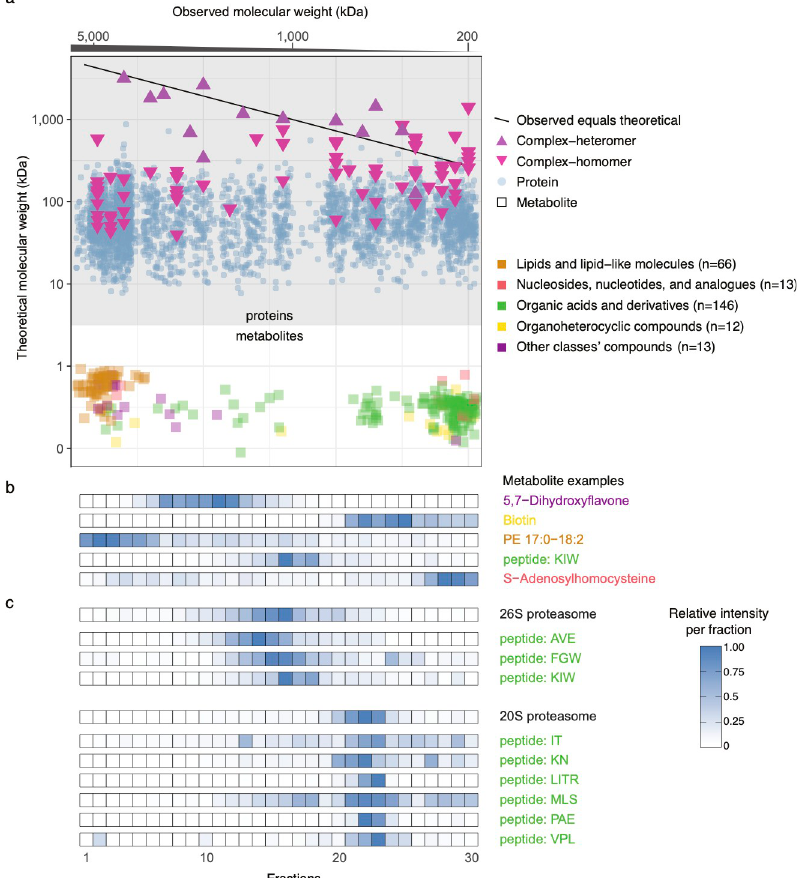
Fig 2. Identified proteins and metabolites. (a) For proteins (top part) and metabolites (bottom part), the relation between theoretical molecular weight and observed molecular weight (according to their elution time) is shown. When proteins are annotated with the molecular weight of heteromeric complexes that they participate in, there is a good correlation between the theoretical and observed molecular weights. Notably, metabolites are observed at molecular weights far above their actual molecular weight. (b) Relative intensity profiles for one example each from the five classes of identified metabolites. (c) Relative intensities of the 20S and 26S proteasomes and co-eluted peptides.